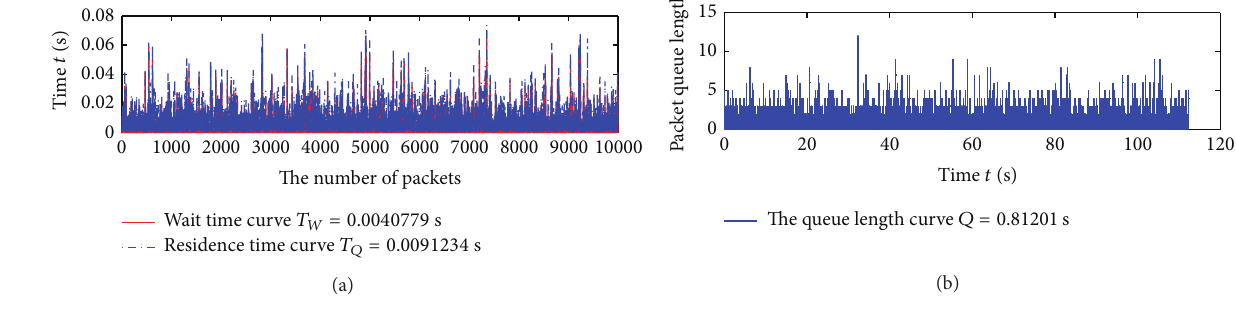
Figure 6: The curve of the time and queue length in the queuing model without priority.